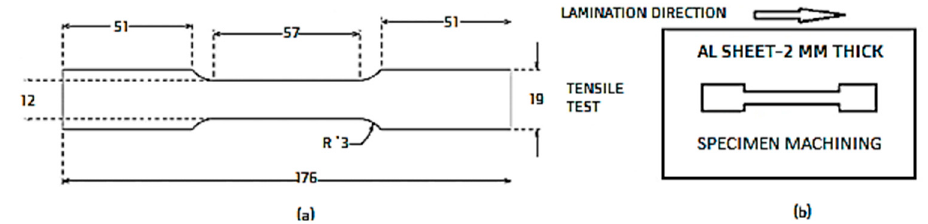
Figure 1. ( a ) Dimensions of the specimens (in mm) used in the tensile test and fatigue test, ( b ) orientation of the specimens with respect to the rolling direction of the metal